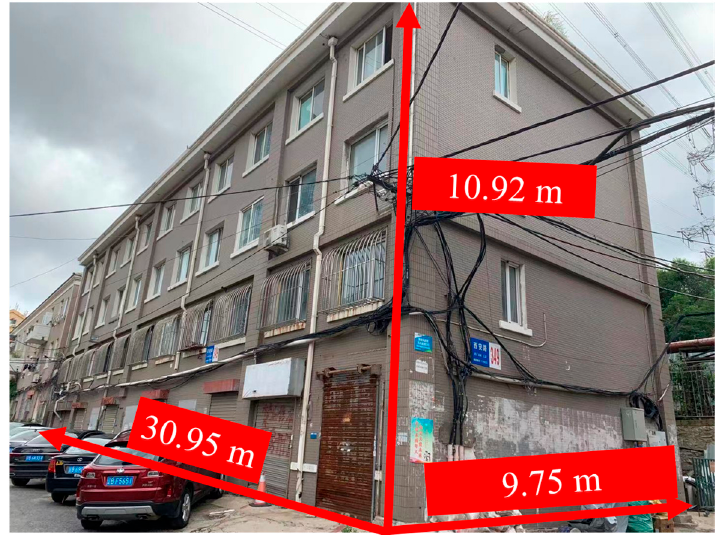
Figure 6. Dimensions of the target building.